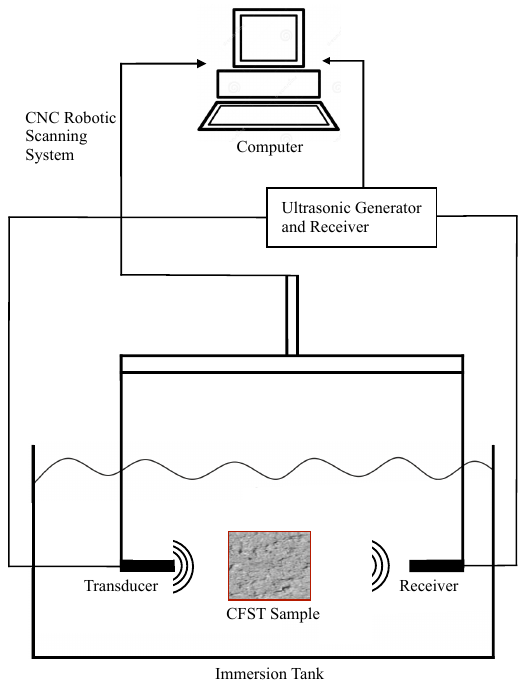
Figure 2. Experimental setup.